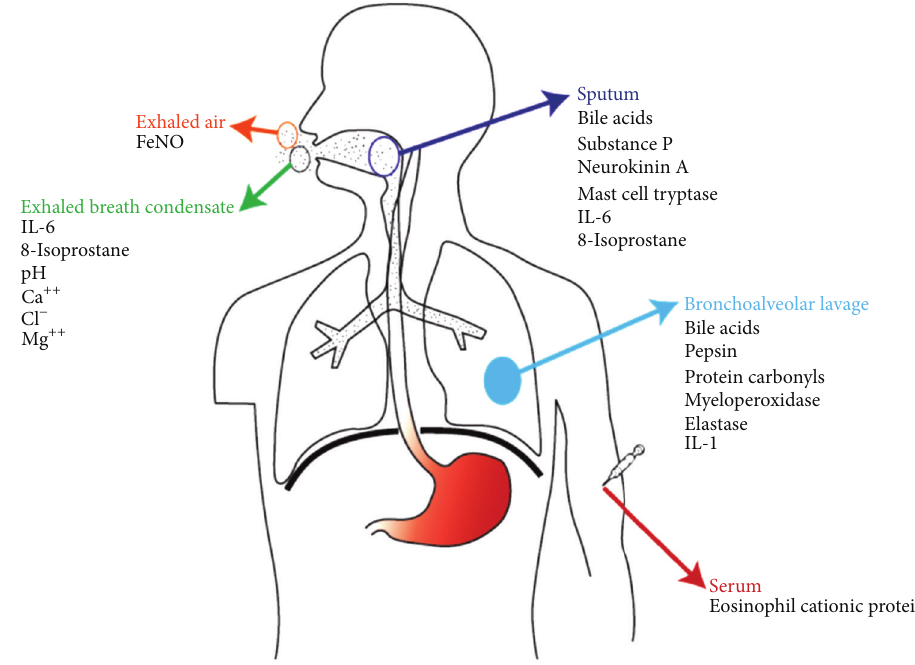
Figure 2: Summary of biomarkers shown to have an association with gastroesophageal reflux in respiratory illnesses.